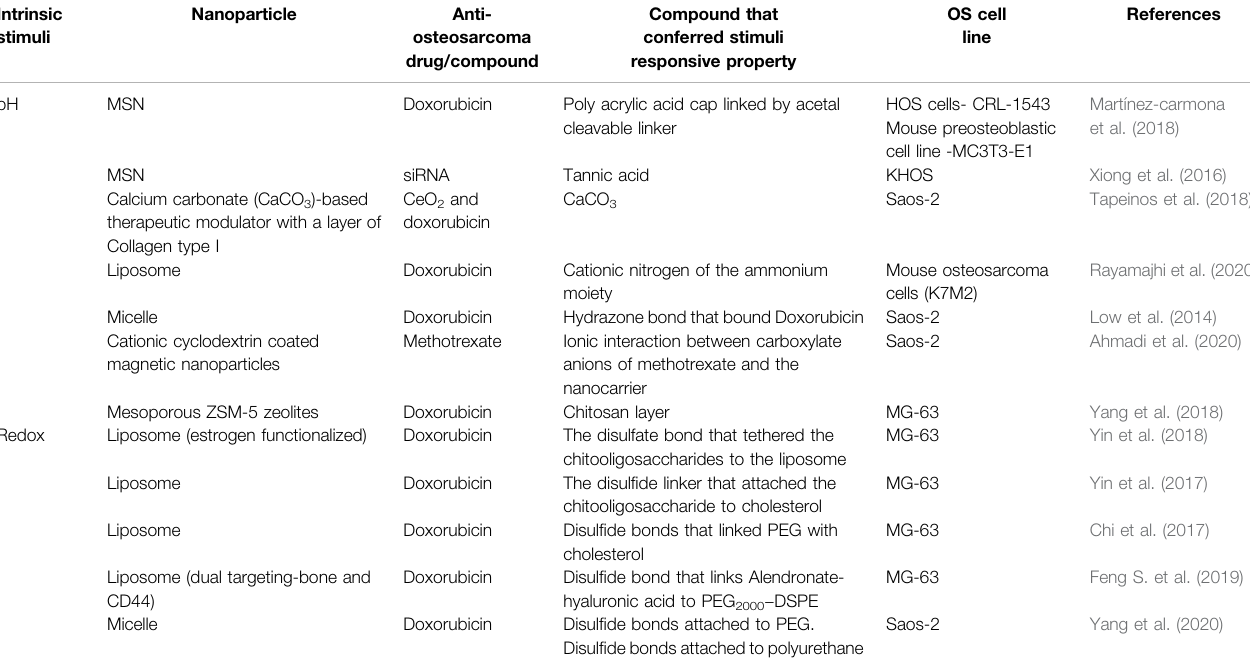
TABLE 4 | Information on strategies utilized to confer intrinsic stimuli properties to nanoparticles as well as the anti-osteosarcoma drugs and cell lines utilized. Intrinsic